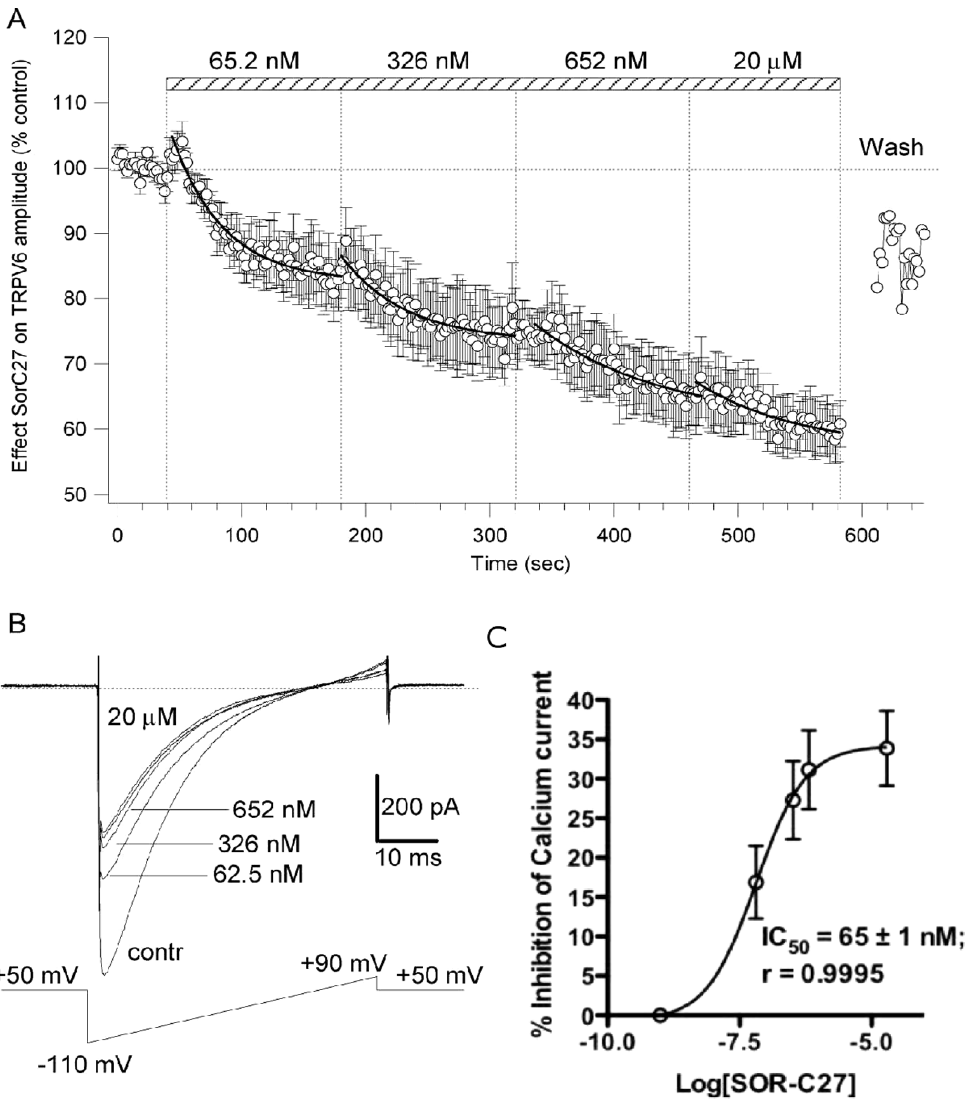
Figure 3. SOR-C27-mediated reduction of TRPV6 current amplitude in TRPV6/EGFP HEK-293 cells. The time course of the SOR-C27- induced reduction in TRPV6 current amplitude for normalized TRPV6 current amplitudes (%) are plotted as a function of time for SOR-C27 concentrations of 65.2 nM, 326 nM, 652 nM and 20 m M ( n =5) ( A ). The bar indicates the period of SOR-C27 application. Examples of traces of TRPV6 currents with each trace being an average of 10 traces ( B ). Dose–response curve for SOR-C27 with error bars representing SEM ( C ).